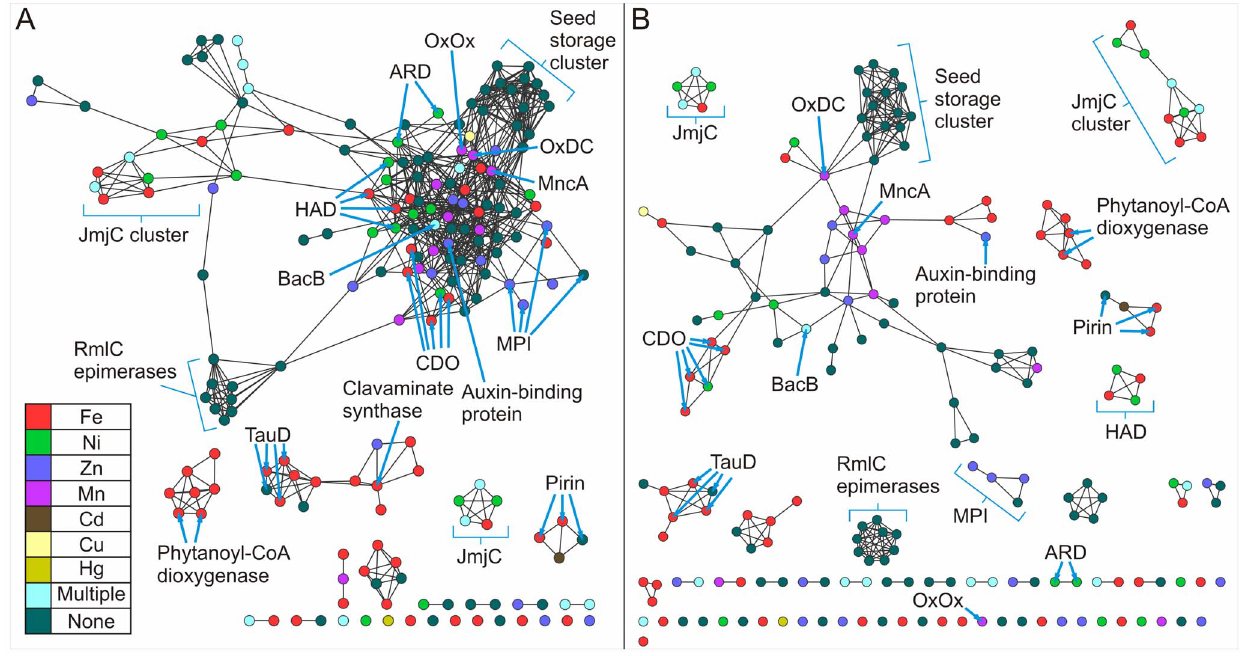
Figure 6. Sequence similarity networks colored by metal ligand. Networks were generated by all-by all BLAST comparisons of the 183 sequences corresponding to the unique cupin structures shown in Figure 3. Nodes were arranged using the yfiles organic layout of of Cytoscape version 3.0. A. Edges between nodes are drawn only if the E-value is better than of 1E-3.5. At this cutoff, edges at this threshold represent alignments with a median 32.1% identity over 93 residues. B. Edges between nodes are drawn only if the E-value is better than of 1E-6.0. At this cutoff, edges at this threshold represent alignments with a median 36.2% identity over 185 residues.